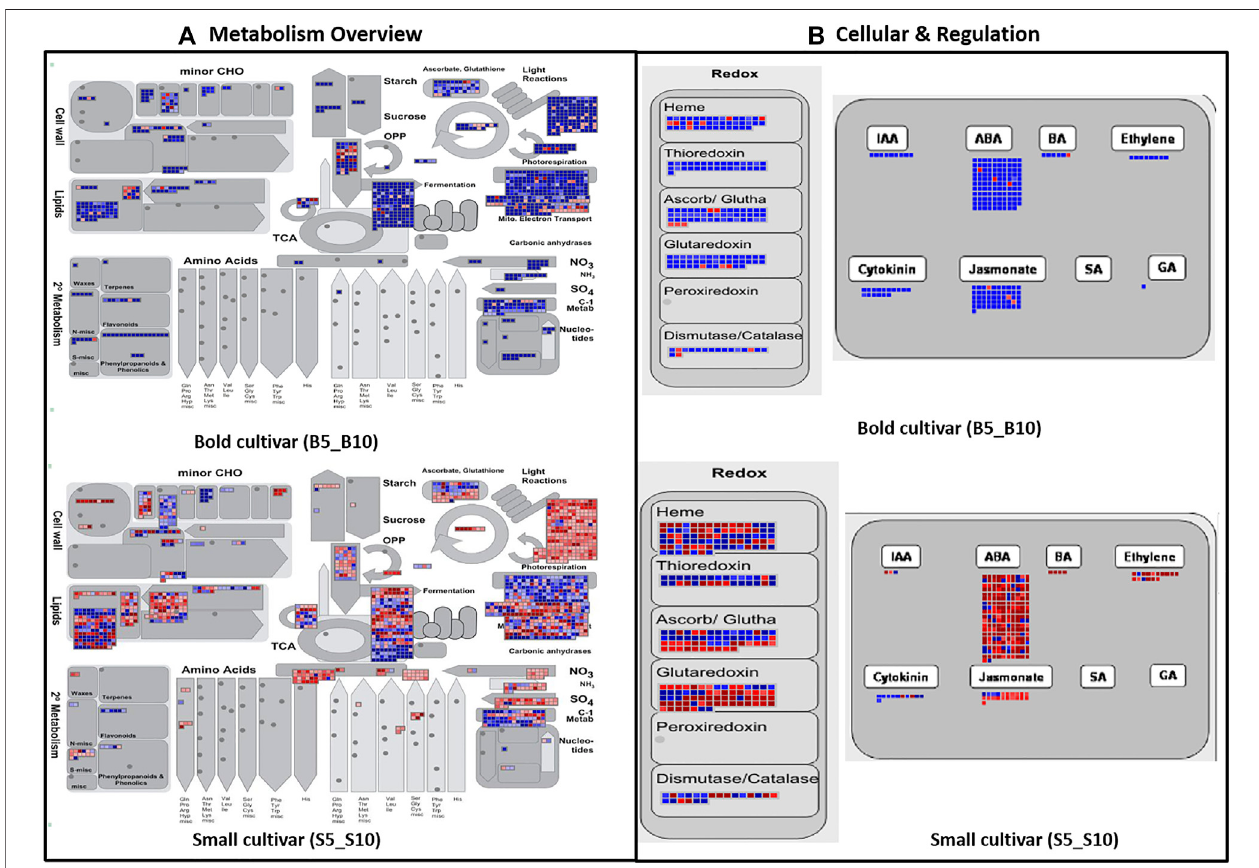
FIGURE5| MapMan pathwayrepresentingthedifferentialexpressionofgenesacrossthetimepointinvolvedin (A) metabolism (B) cellularandregulationpathway in bold and small genotypes.